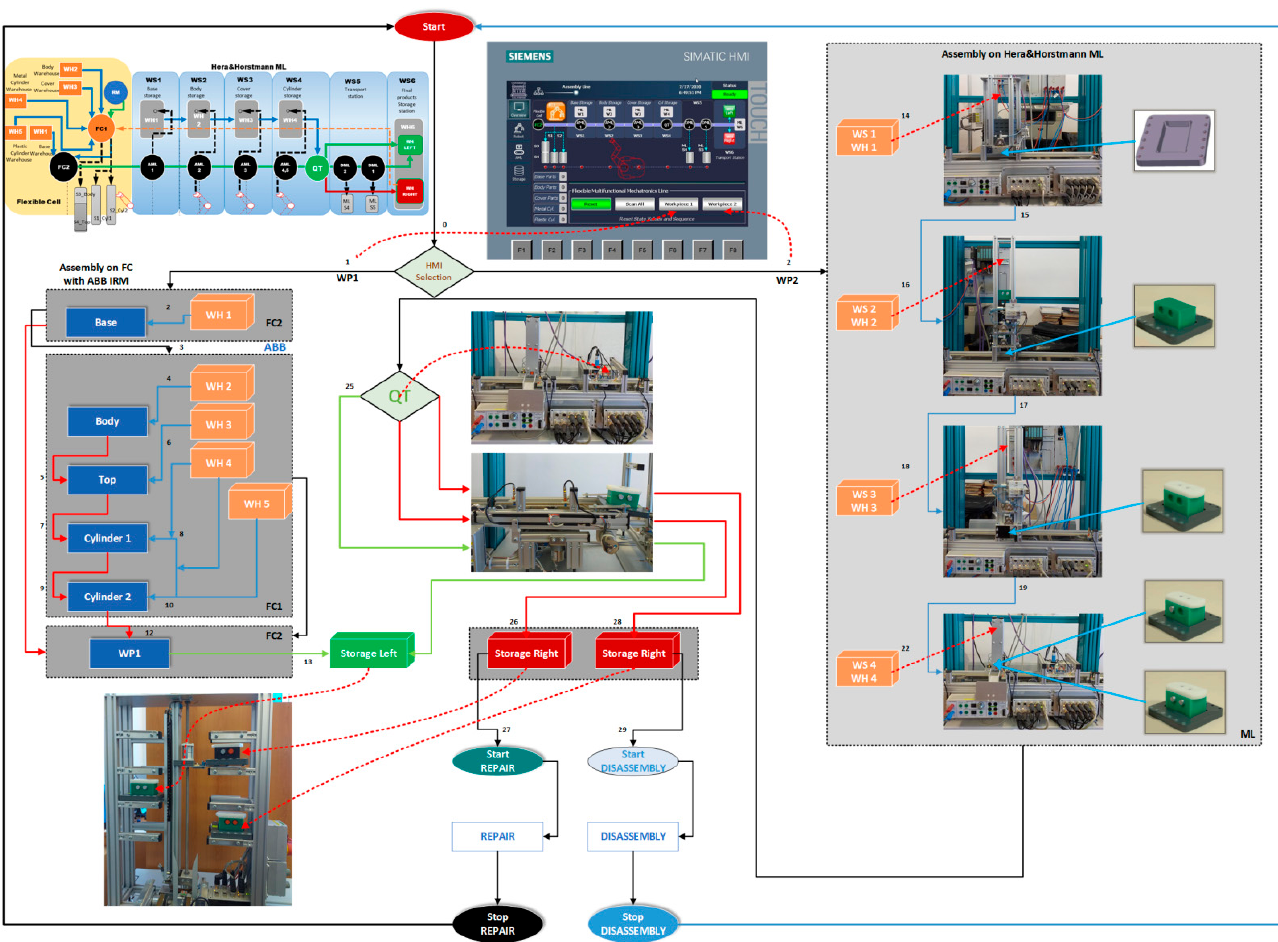
Figure 7. Task planning and synchronization for assembly: WP1 on FC and WP2 on A/DML.